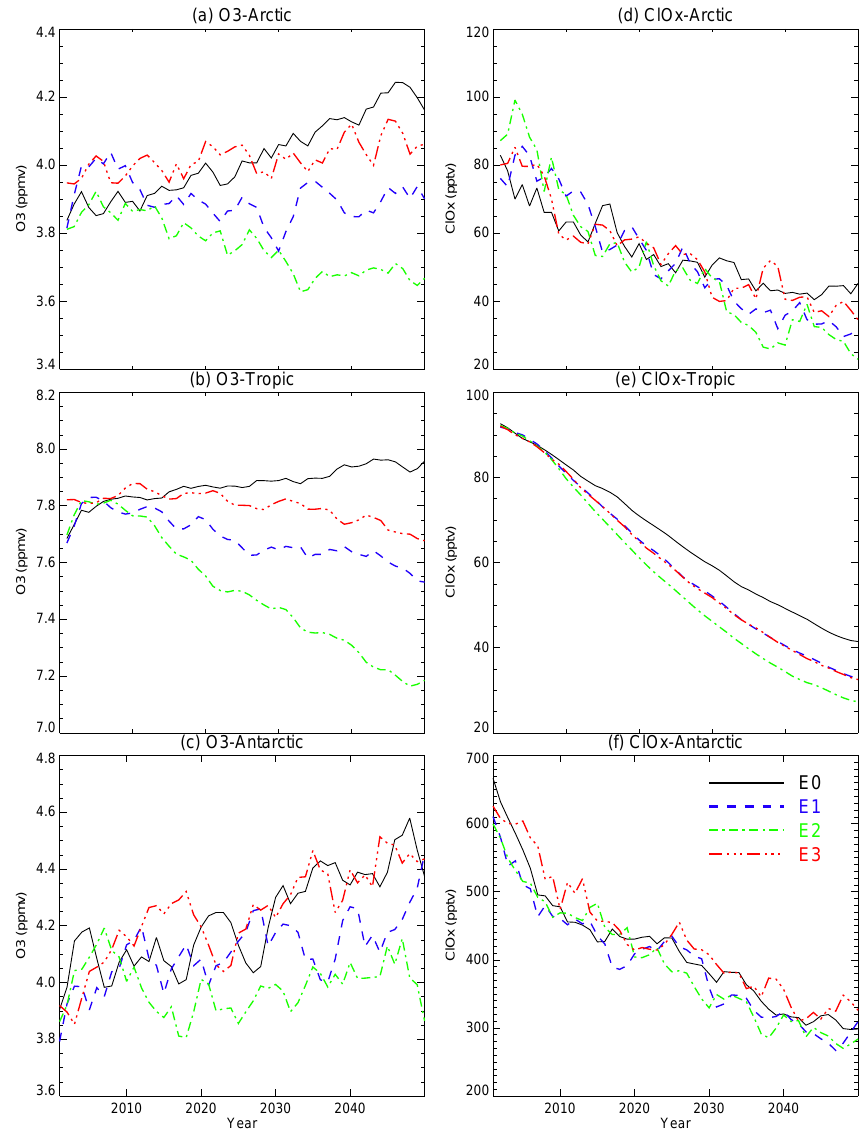
Figure 4. Time series of mean (a, b, c) ozone and (d, e, f) Cl x (Cl x = Cl + ClO + 2 Cl 2 O 2 ) between 20 and 10hPa averaged over (a) Arctic (60 ◦ N–90 ◦ N), (b) Tropics (22 ◦ N–22 ◦ S) and (c) Antarctic (60 ◦ S–90 ◦ S) in E0 (black line), E1 (blue line), E2 (green line) and E3 (red line). The time series has been smoothed by nine-point